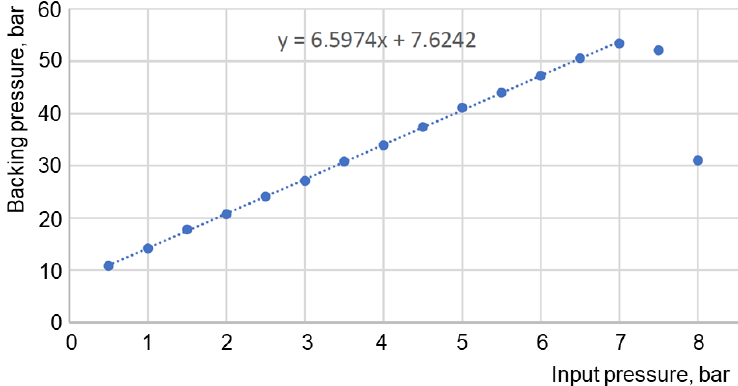
Figure 9. Dependence of the compressed gas pressure on the input gas pressure (edited figure from Ref. [34]).